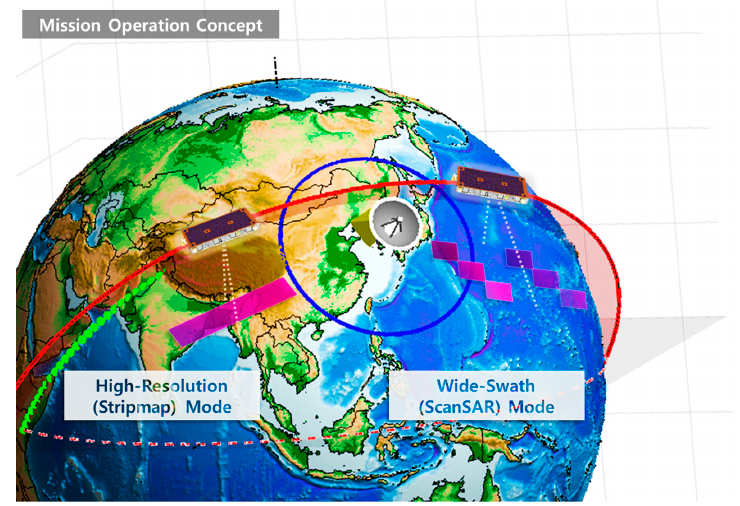
Figure 2. Operating concept of the S-STEP mission in the high-resolution and wide-swath modes. The frozen orbit and repeat ground track (RGT) orbit are considered during the design of the satellite constellation orbits to enhance the mission plan efficiency and usability of the SAR images. In this study, the RGT orbit was designed with an altitude range of 510 ± 10 km and repeated every 14 d to facilitate mission planning. To minimize the revisit time for the region of interest up to ~30 min, the orbit inci- dence angle was selected according to the longitude of the region of interest and subse-